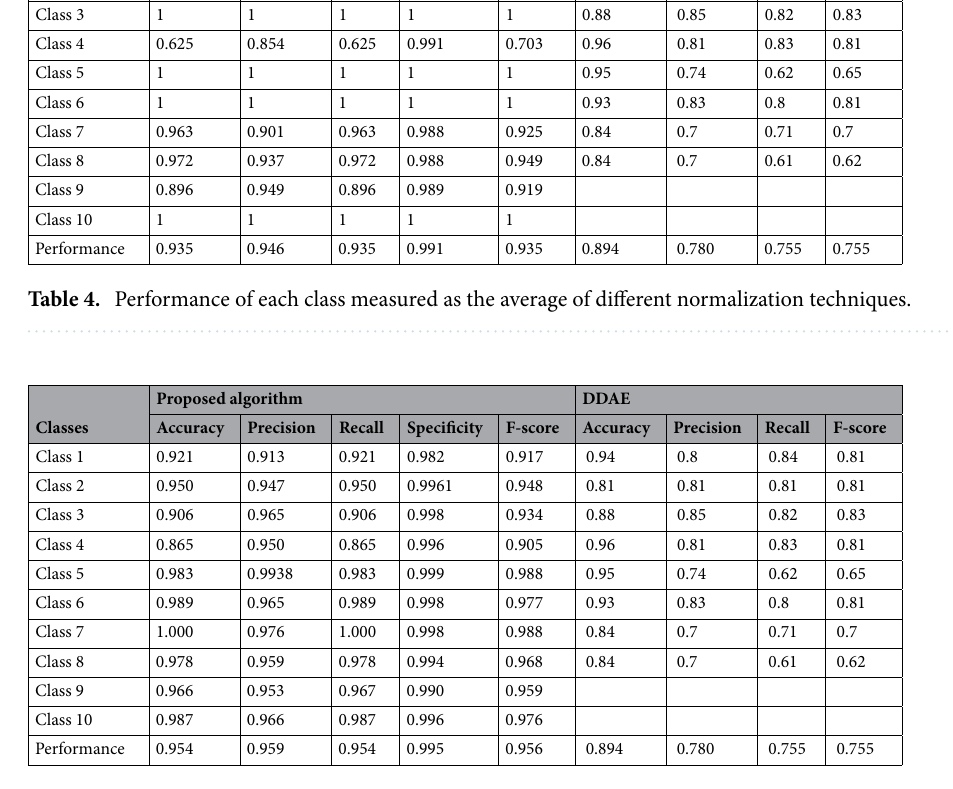
Table 5. Performance of the model when the training data set is all normalized